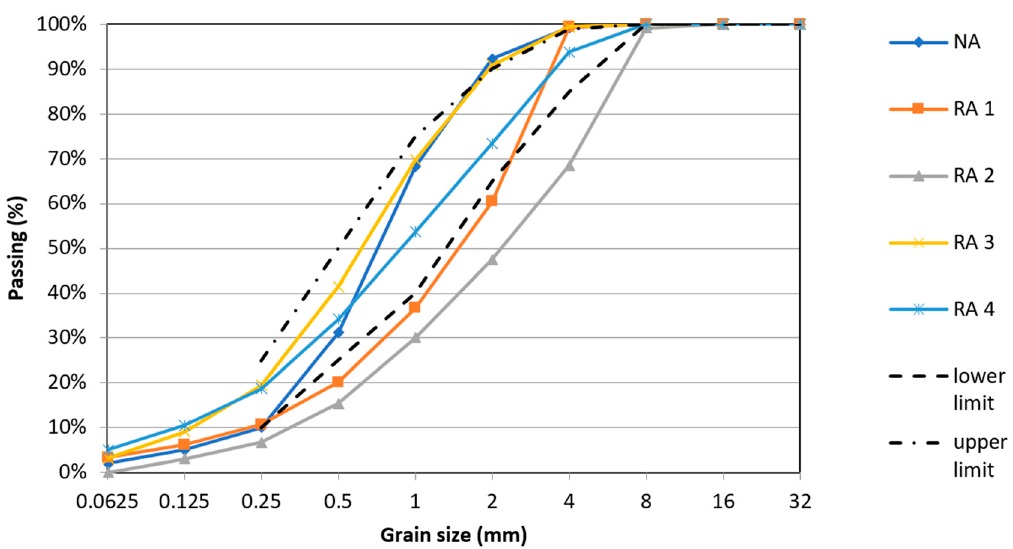
Figure 3. The particle size distributions of natural aggregate (NA) and RCA (grain size 0/4 mm) according to CSN EN 933-1. Table 1. Basic geometrical properties.